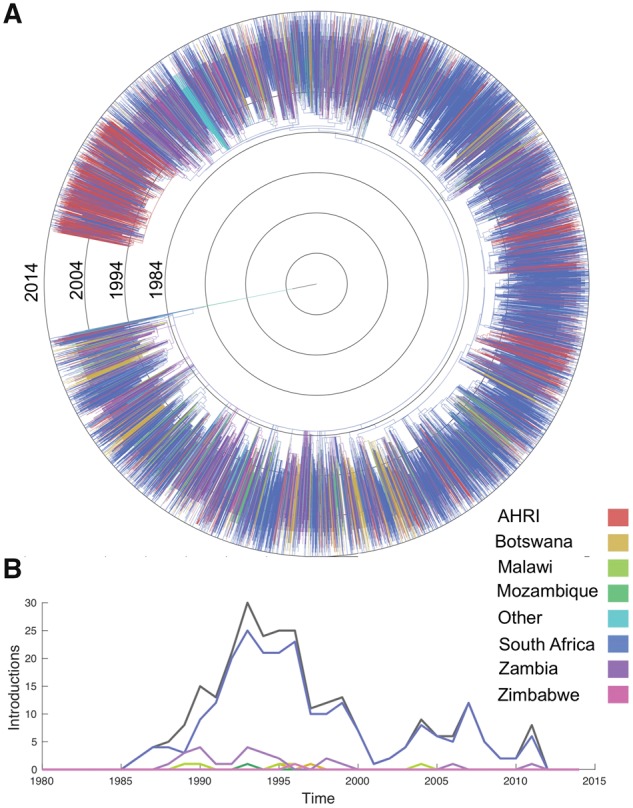
The local HIV epidemic in the AHRI study population within the larger phylogenetic context of the southern African subtype C epidemic. (A) ML phylogenetic tree reconstructed from HIV pol sequences from the AHRI (local) along with the regional background dataset. Tips are colored by sampling location, internal branches are colored according to their ancestral location reconstructed via maximum parsimony. (B) Time series showing the temporal distribution of external introductions from each country into the local population, as identified by maximum parsimony. The black line gives the total number of introductions summed over all countries.